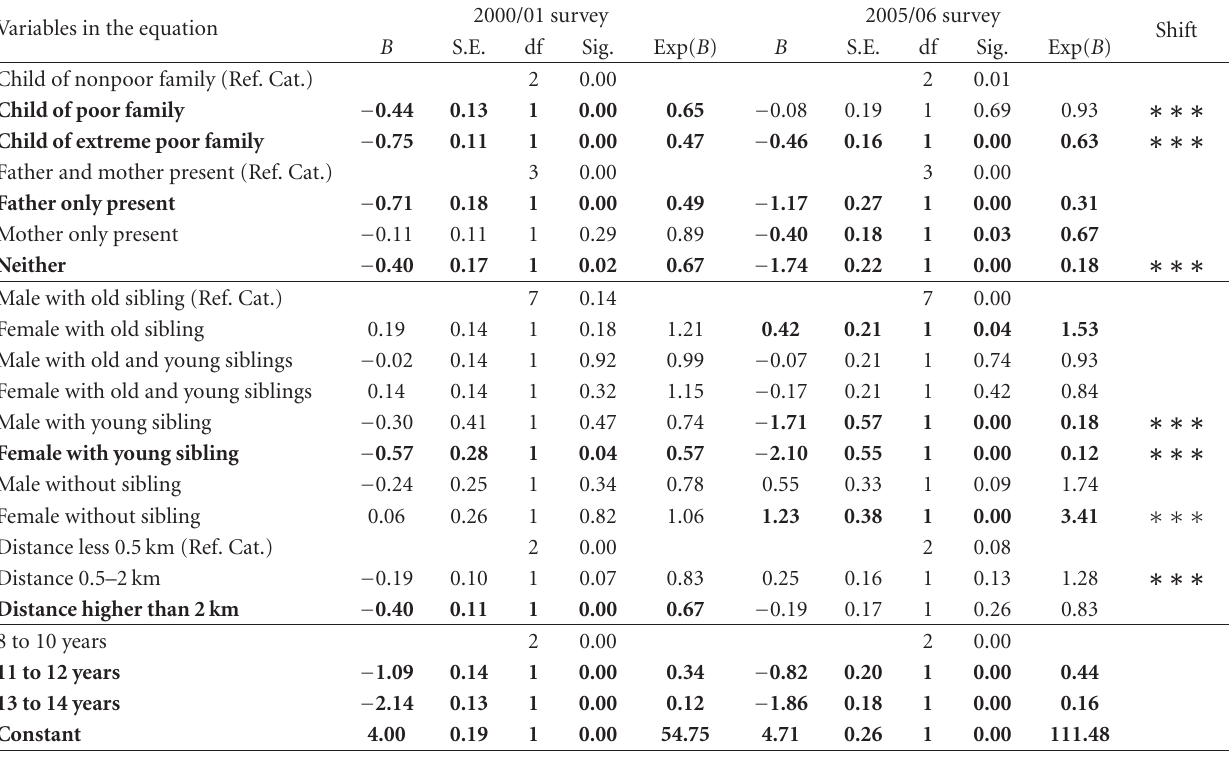
Table 2: Binary logistic regression model of school attendance in 2000/01 and